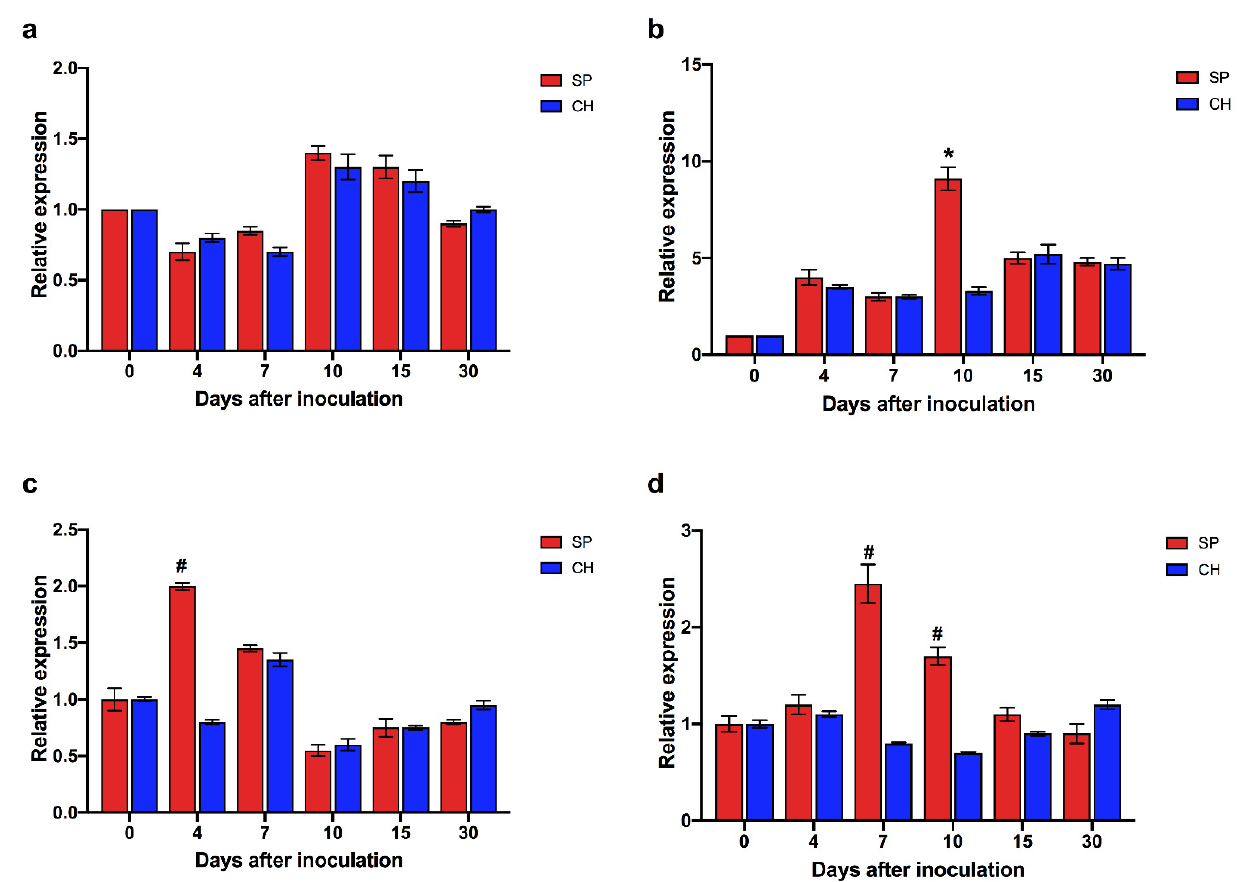
Figure 9. Expression of the ScTIR1 and ScNAC1 genes in roots of plants of the SP and CH genotypes not inoculated and inoculated with diazotrophic bacteria. ( a , c ) represent the relative expression by qRT-PCR of the ( a ) ScTIR1 and ( b ) ScNAC1 genes in roots of plants free from diazotrophic bacteria of the BNF-contrasting genotypes. ( c , d ) represent the relative expression by qRT-PCR of the ( c ) ScTIR1 and ( d ) ScNAC1 genes in roots of control and G. diazotrophicus -inoculated plants of the BNF-contrasting genotypes. Relative mRNA levels were analyzed by qRT-PCR and were normalized by the levels of the 28S and GAPDH normalizers and ( a ) the 0-day point or ( b ) the uninoculated control on the same day of collection was used as a reference for the calculation of relative expression. Each root RNA sample was prepared from a pool of 15 plants, and the figure shows the average of three biological replicates where technical triplicates of the qRT-PCR reactions were performed. Statistical analyses were performed by t-test with p < 0.05. The symbol (*) indicates significant differences in the expression of ScNAC1 in roots of plants free of diazotrophic bacteria between SP and CH at the same time point. The (#) sign indicates significant differences in expression between control and inoculated plants of the same genotype and at the same collection point. Bars indicate mean ± standard deviation of three independent experiments.